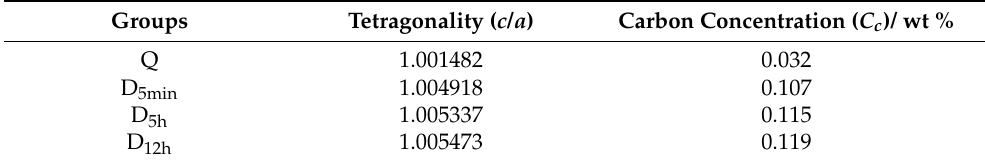
Table 3. The martensite tetragonality and carbon concentration.